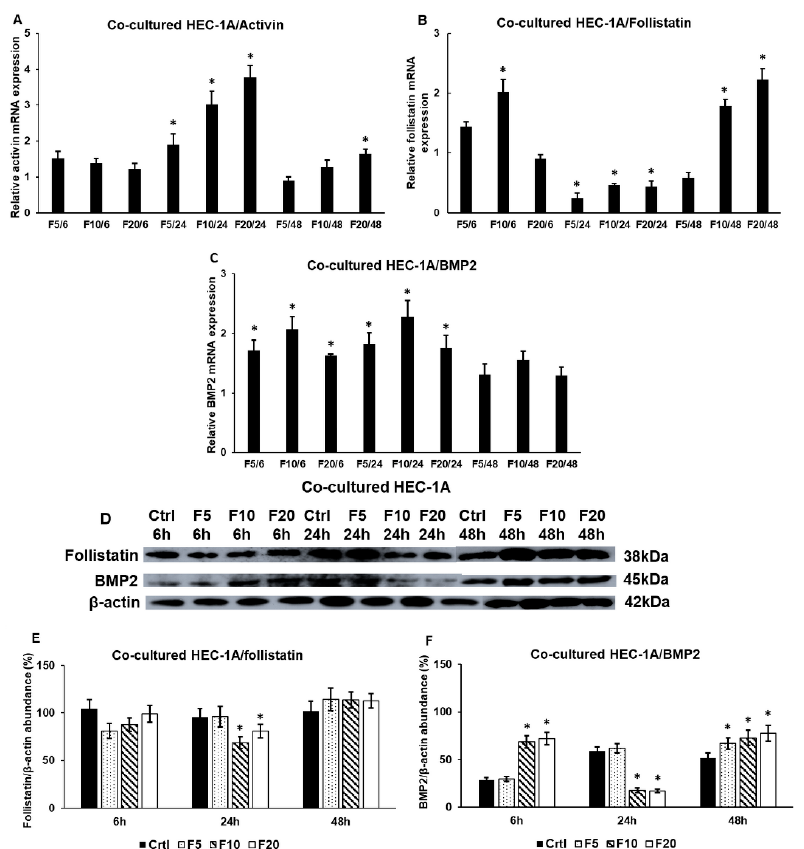
Figure 5. Expression analysis of activin, follistatin and BMP2 in co-cultured HEC-1A cells. Real-time PCR was performed with SYBR green protocol using gene specific primers. β -actin was used as house-keeping gene for the normalization. The relative expression of untreated controls was regarded as 1. The mRNA expressions of the treated cells were compared to their appropriate controls (6 h, 24 h or 48 h). HEC-1A cells were collected by trypsinization directly from the coverslips. The cells were lysed and their protein contents were measured. The same amount of protein (15 µ g) from each sample was separated by SDS-PAGE using 10% or 12% polyacrylamide gel, transferred by electroblotting to nitrocellulose membranes. The membranes were incubated with anti-follistatin and anti-BMP2 polyclonal rabbit antibodies according to the manufacturer’s protocols. The experiments were repeated three times. ( A – C ) mRNA expression levels of activin, follistatin and BMP2. ( D ) Western blot analyses of follistatin and BMP2. ( E , F ) Optical density analyses of the examined proteins in HEC-1A cells. The analyses were carried out using ImageJ software; the optical densities of the examined proteins were expressed as percentage of target protein / β -actin abundance. The columns represent mean values and error bars represent standard deviation (SD) for three independent experiments ( n = 3). The * mark p < 0.05 compared to the controls. Abbreviations of fractalkine treatments: 5 ng / mL-F5; 10 ng / mL-F10; 20 ng /